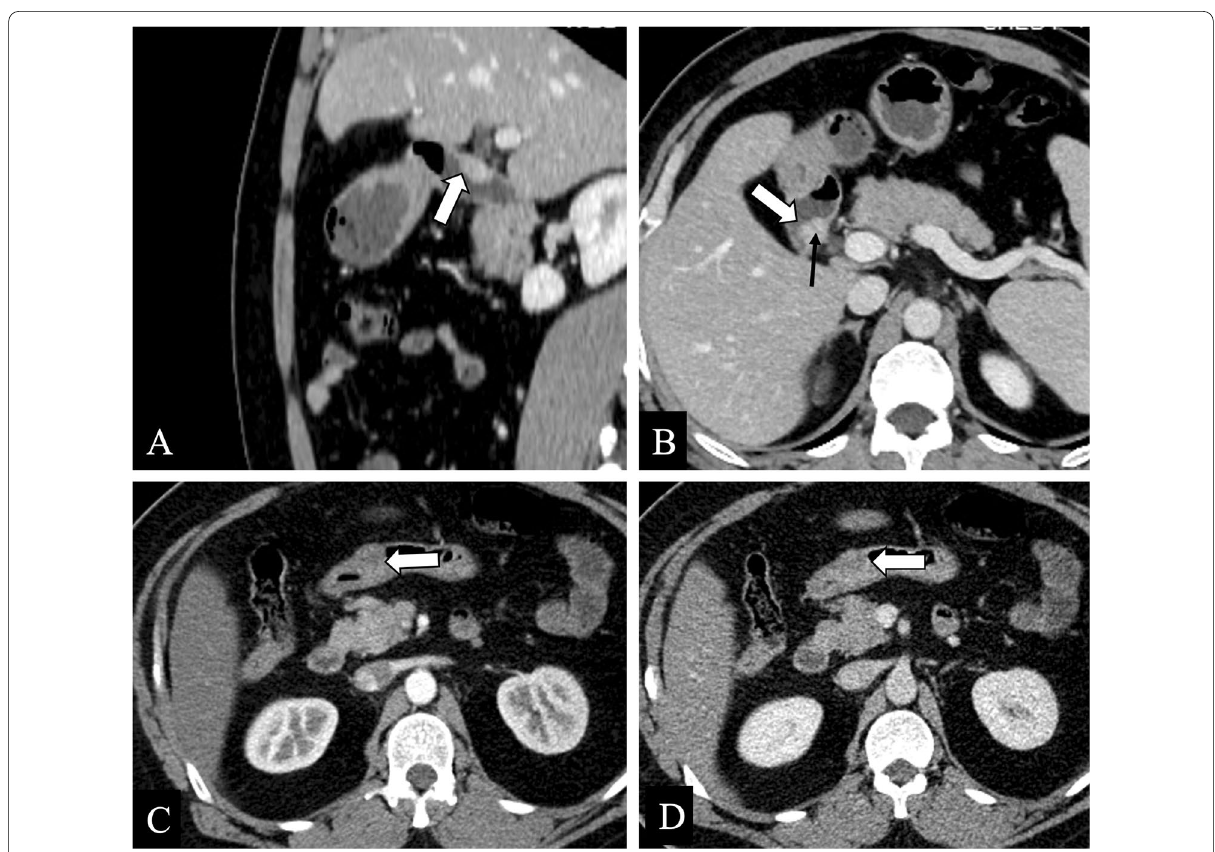
Fig. 6 a, b Coronal and axial enhanced CT images of a heterotopic pancreas in the duodenum of a 53‑year‑old male showed a 1.3 cm endoluminal lesion (white arrows) with a lobulated margin, presenting round contour on axial image while flat pattern on coronal CT image. Small duct‑like structure (black arrow) was seen within the lesion, which measured with a long diameter to short diameter > 1.4 on coronal CT image. c, d Axial enhanced CT images of a heterotopic pancreas in the gastric antrum of a 58‑year‑old male showed a 1.2 cm endoluminal lesion (white arrows), with a long diameter to short diameter >